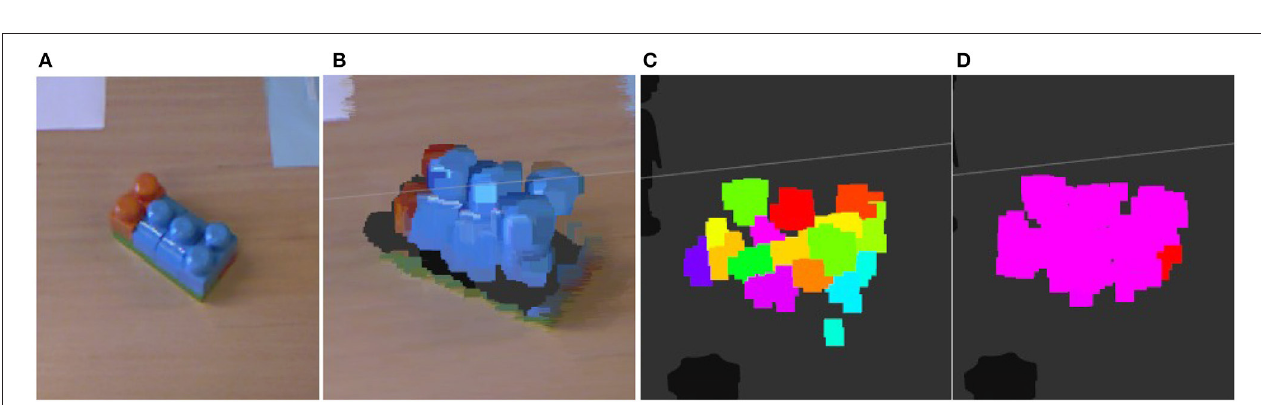
FIGURE 4 | Set of pre-defined actions for three actors: Baxter gripper equipped with a 7 d.o.f. arm, and an electrical gripper attached to it, Baxter nogripper equipped only with a 7 d.o.f. arm, and Katana 5 d.o.f. arm without gripper. Poke is the only pre-defined action of actor Baxter nogripper , and side push the only pre-defined action of Katana. The arrows show the direction of the manipulator movement. The arcs show the position of the gripper with respect to the object, while the black bullet represents the object.